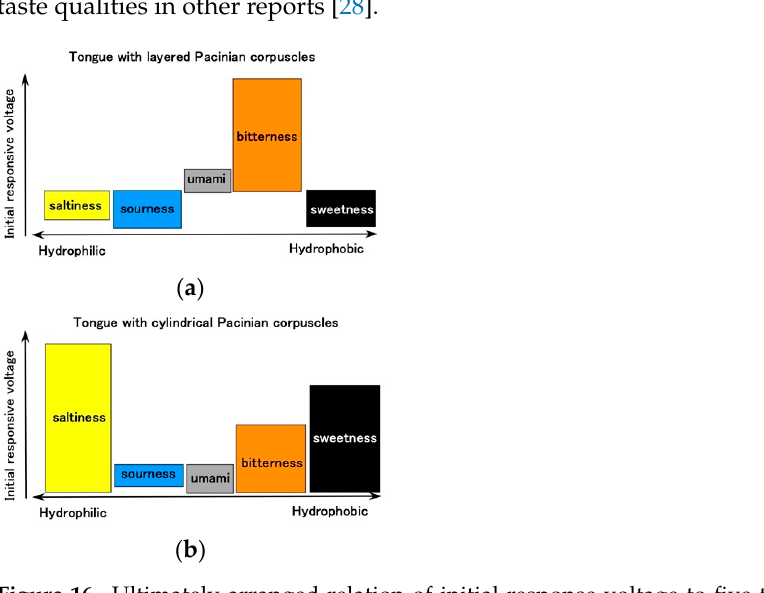
Figure 16. Ultimately arranged relation of initial response voltage to five tastes: ( a ) for layered Pacinian corpuscles; and ( b ) for cylindrical Pacinian corpuscles.